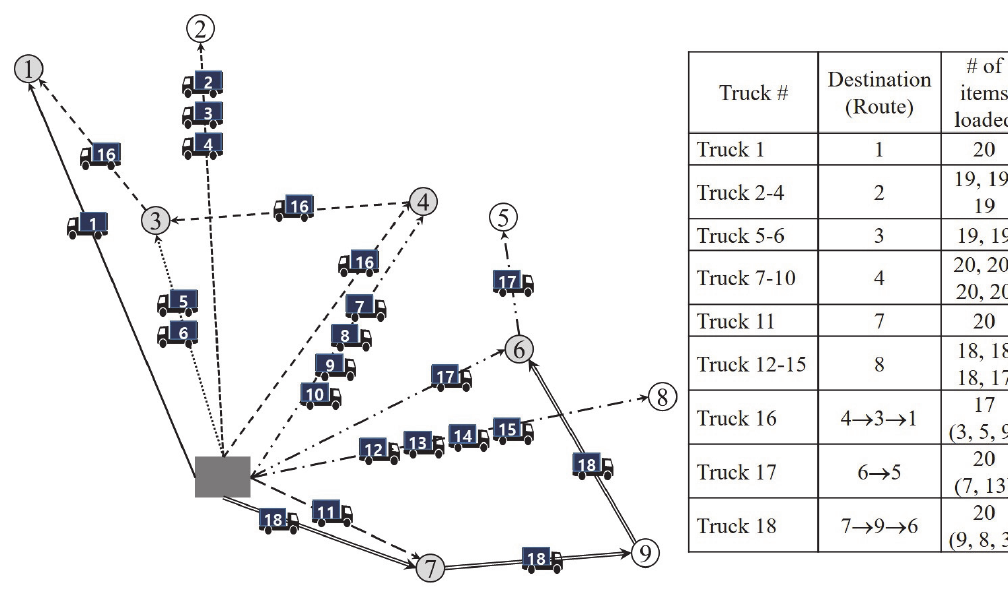
Fig. 2. Graphical representation of sequential batching for results shown in Table 2 Multiple deliveries and receipts occur for five destinations (i.e., destinations 1, 3, 4, 6, and 7) in the first decision, as depicted in Fig. 2, whereas multiple receipts for more destinations (i.e., 1, 3, 4, 6, 7, and 8) occur in the second decision, as depicted in Fig. 3. Multiple deliveries from heterogeneous truckloads occur inevitably because there exist some remnants (not loaded at Level 1) for several destinations due to the minimum load requirement and the truck capacity. A similar situation to that of multiple deliveries also exists when forming input release lots in semiconductor wafer fabrication, wherein a cluster consists of product types. As mentioned earlier, it is necessary to make a certain number of heterogeneous wafer lots owing to the productivity issue and the lot size requirements. These heterogeneous wafer lots cause lot-splits during the wafer fabrication process. It is important to effectively control the DoH determined by heterogeneous truckloads or heterogeneous wafer lots that causes multiple deliveries or lot-splits, because they are directly related to the total processing cost of items. As shown from the two decisions for the truck-loading example, the number of destinations where multiple deliveries occur can be decreased when the number of items loaded in each truck is determined as the value between the minimum requirement and the maximum truck capacity, instead of filling items up to the maximum truck capacity. We use the MQC constraint for effective control over the DoH . We explain the MQC constraint in more detail in the following section. Also, the non-exclusiveness of the AHCS should be considered to complete the sequential batching process at a lower